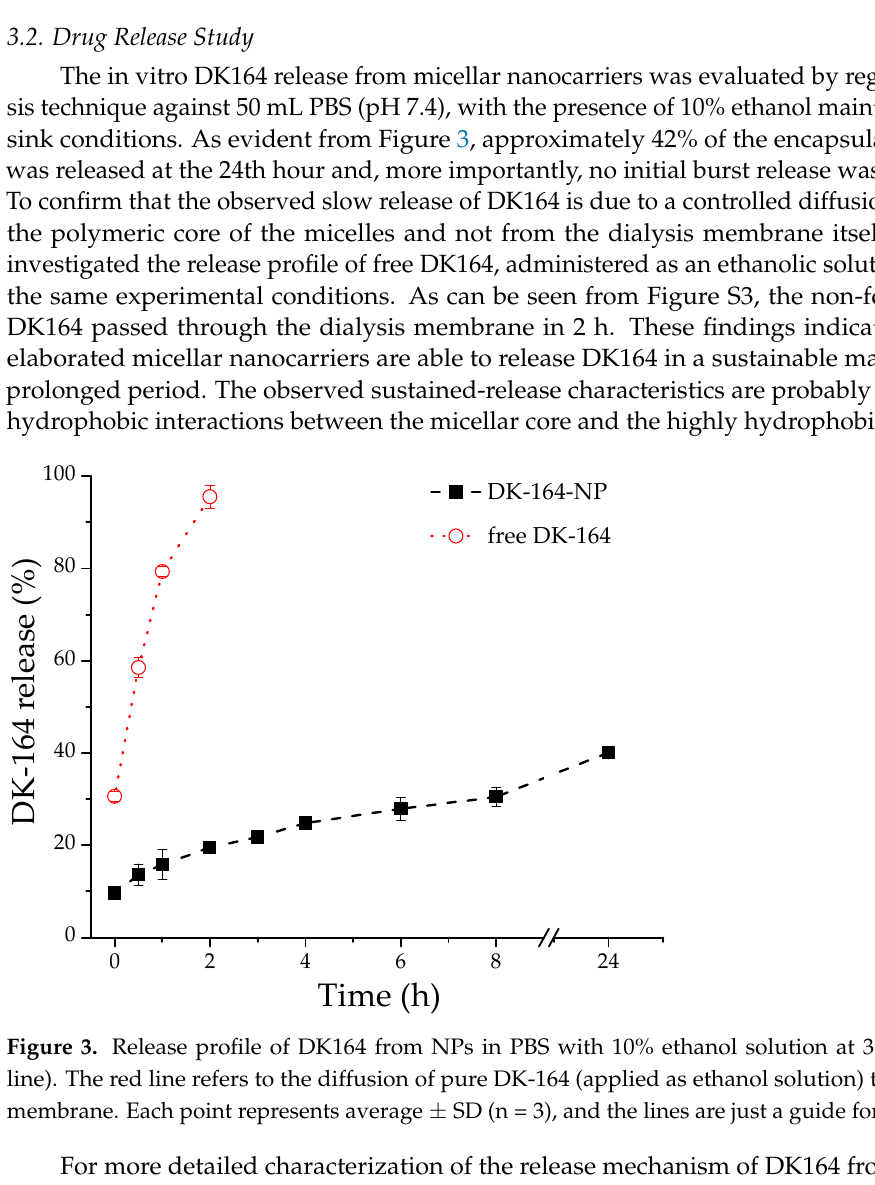
Figure 4. Cell viability assay: cancerous (A549, H1299) and non-cancerous cells (MRC5) were treated with various concentrations of the free compound DK164, the micellar form of the compound